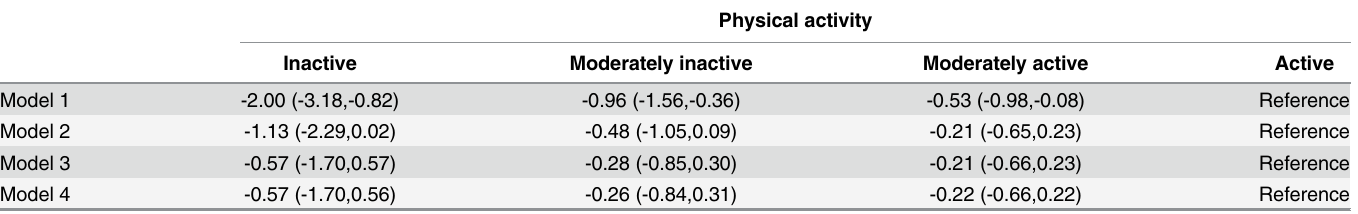
Table 2. Regression coefficients (mL/min per 1.73 m 2 ) and 95% confidence intervals for the association between physical activity and cystatin C- based estimated glomerular filtration rate at the subsequent round, adjusted for time-varying